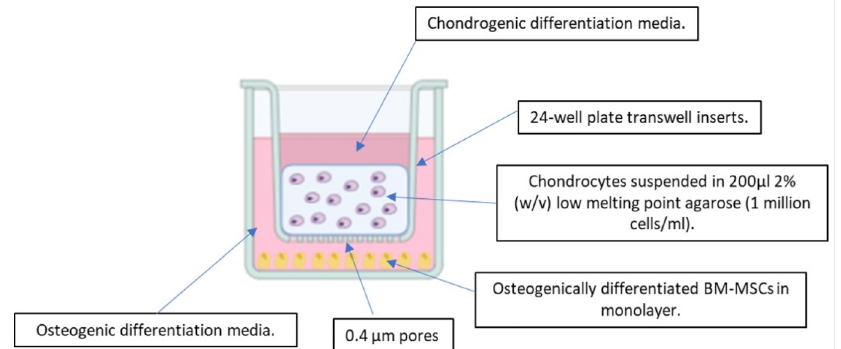
Figure 3. Schematic of the indirect co-culture model (created using Biorender.com). Side view of a single well of an experimental